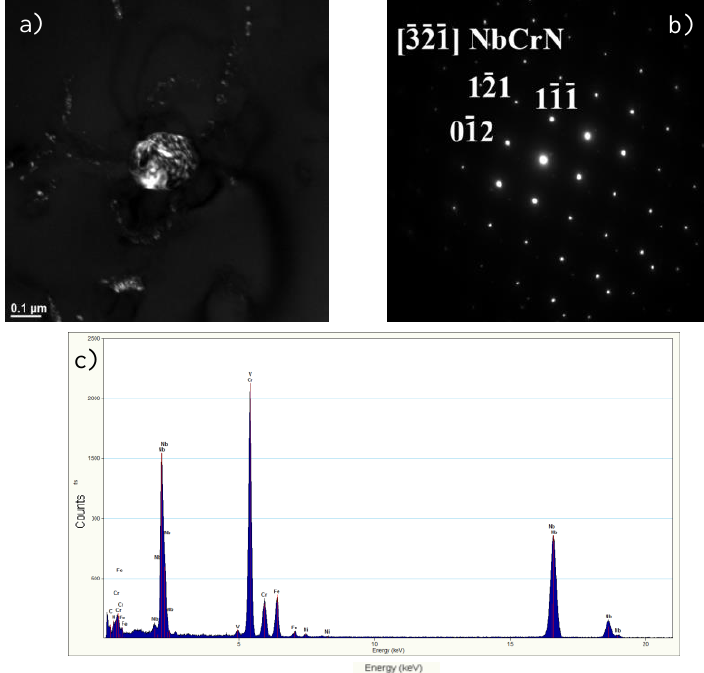
Figure 5. M 23 C 6 carbides at the grain boundaries ( a ), resolved diffraction ( b ), EDS analysis ( c ); TEM.